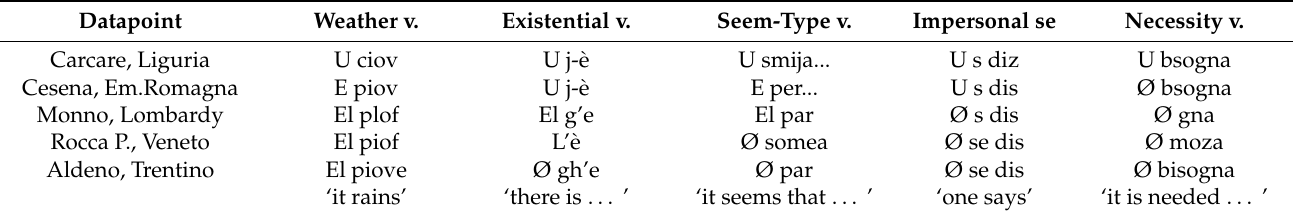
Table 1. Expletive clitics in impersonal environments (from (Pescarini 2014) with minor modifications). Datapoint